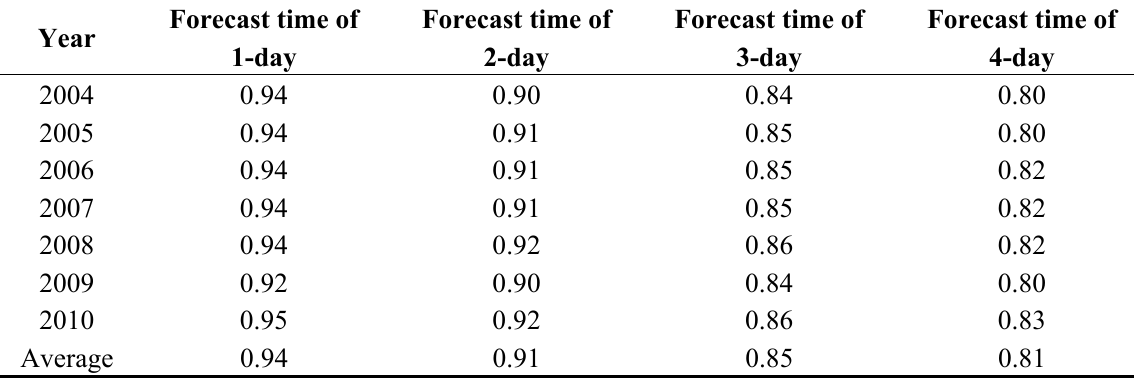
Table 3. Forecast accuracy DC values of original inflow process for the Three Gorges Reservoir from 2004 to 2010.